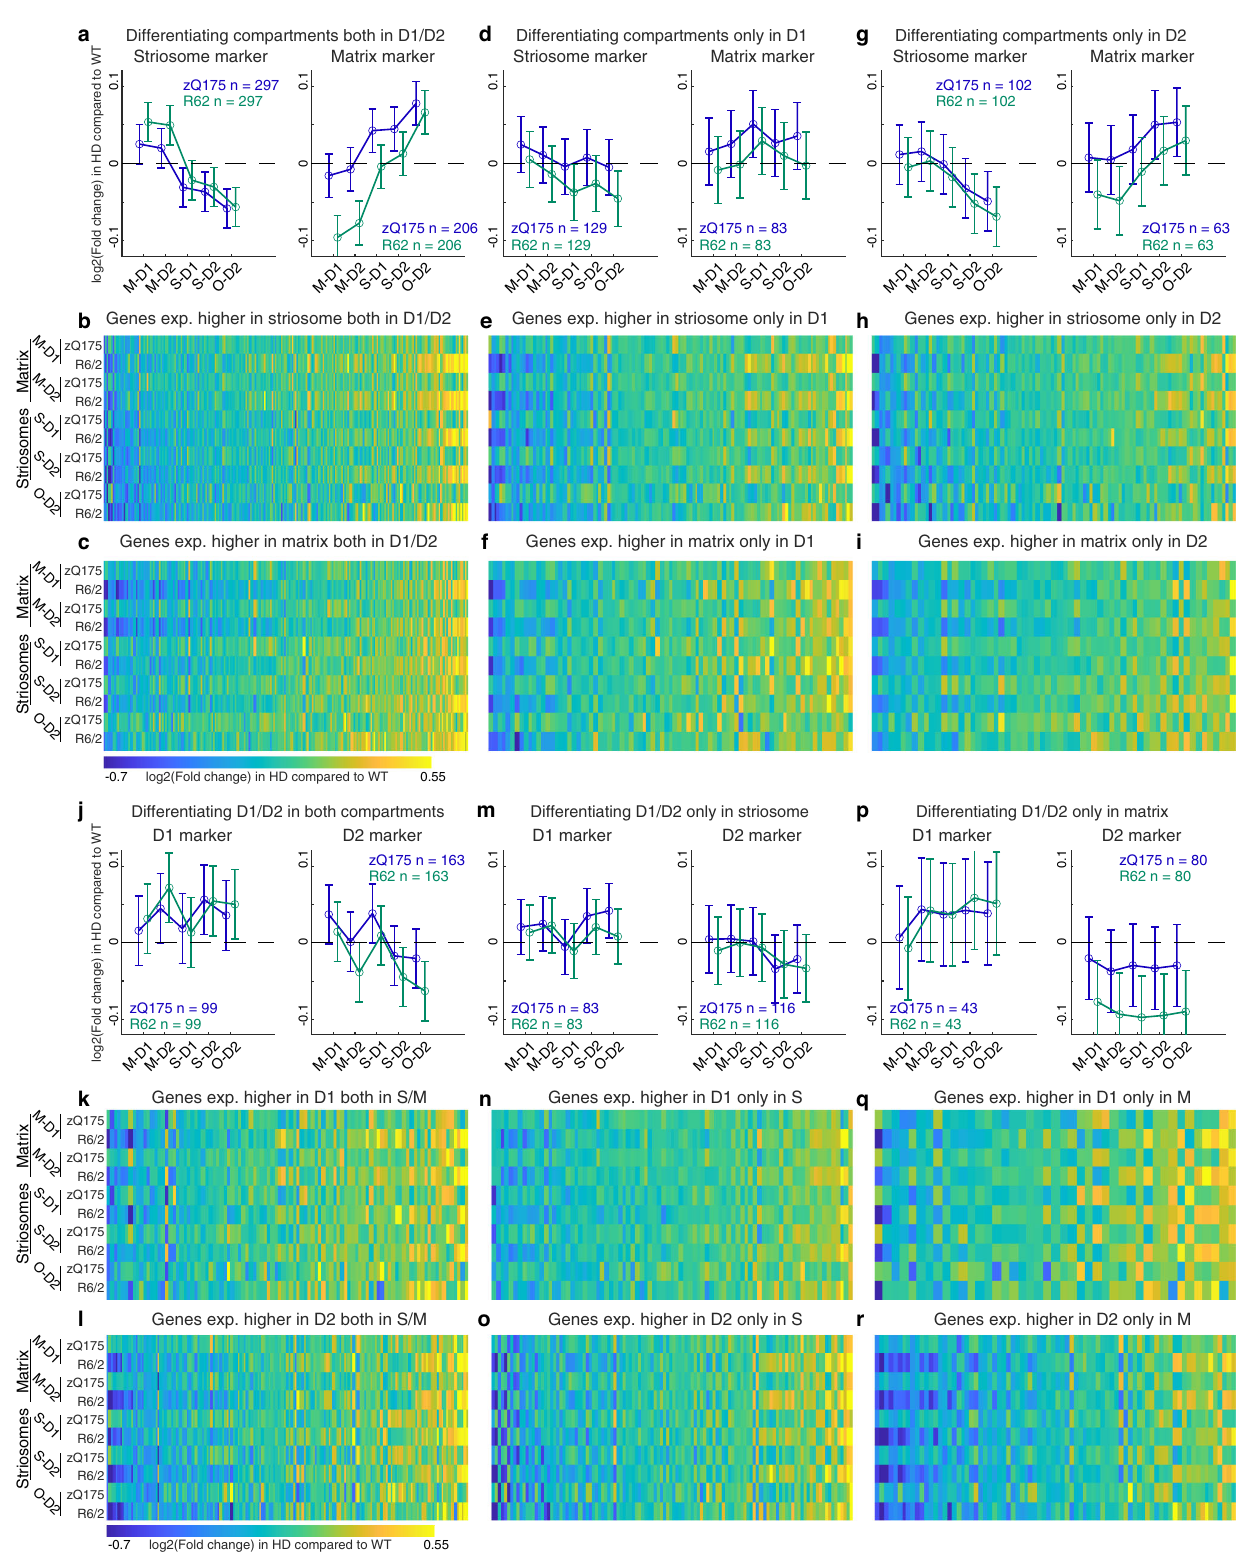
S-M markers but not D1-D2 markers exhibit cell-type-dependent dysregulation that blurs the transcriptomic, discriminative identities of the striatal SPNs in the HD model mice These fi ndings indicated that both SPNs in striosomes and SPNs in matrix exhibited a loss in their endogenous identities. This pattern of dysregulation, tending to cancel differential expressions of S-M Nature Communications| (2023)